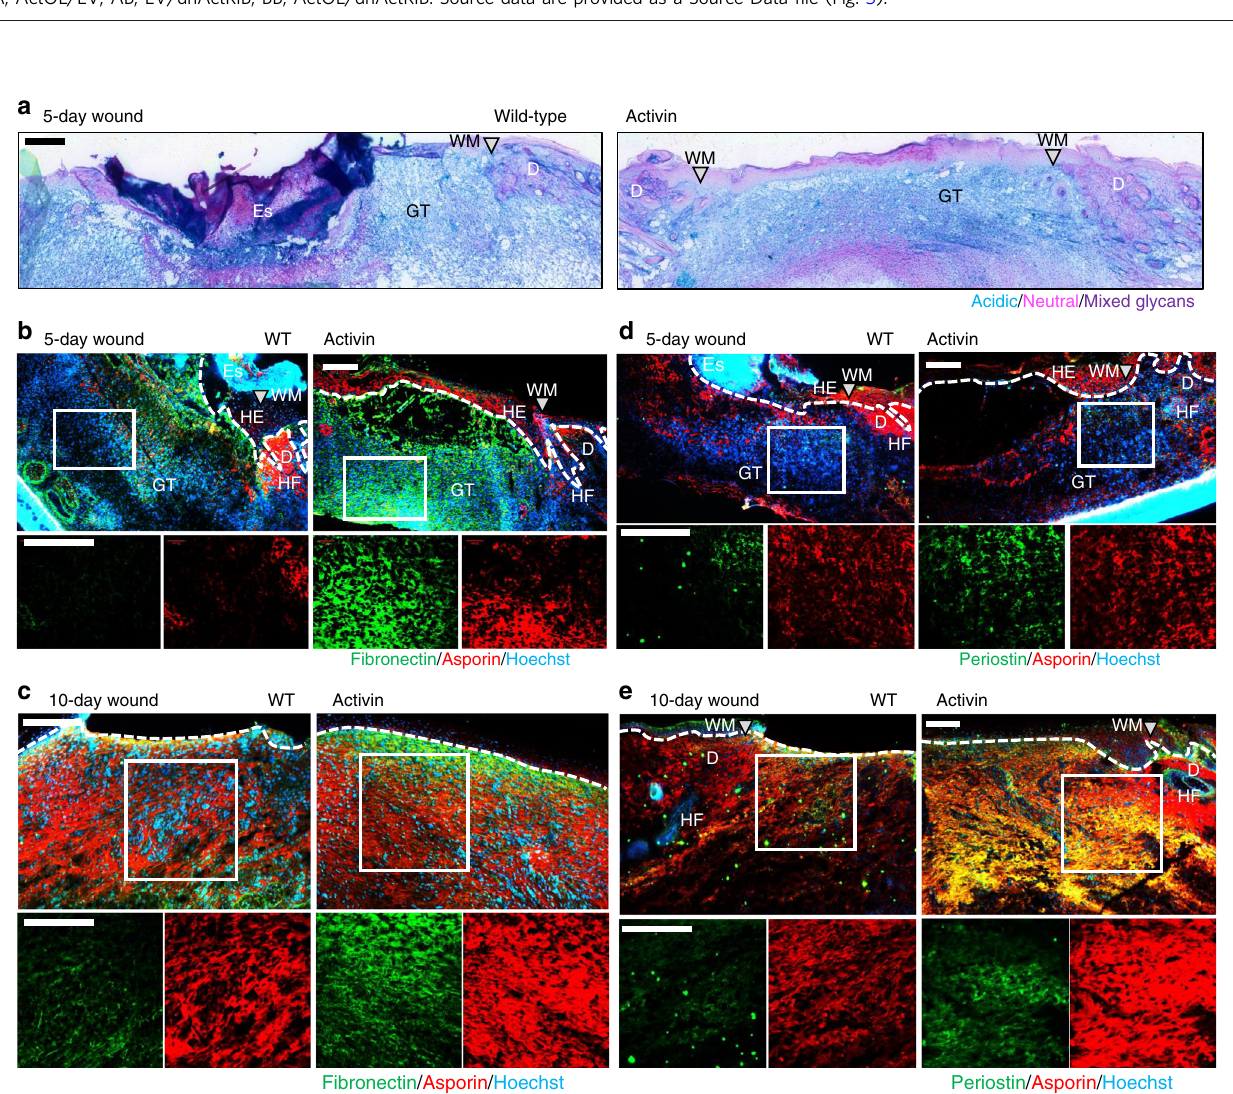
Fig. 6 Activin promotes deposition of wound glycoproteins and proteoglycans. a Representative photomicrographs of Alcian Blue/PAS-stained 5-day wounds show larger areas of acidic (blue) glycans in the wound center of Act vs WT mice. b – e Representative photomicrographs of sections from 5-day ( b , d ) and 10-day wounds ( c , e ) of WT and Act mice stained with antibodies against fi bronectin (green) and asporin (red) ( b , c ) or periostin (green) and asporin (red) ( d , e ). Nuclei were counterstained with Hoechst (blue). Insets indicate the areas within the wound bed centers that are shown at higher magni fi cation below. Stainings were performed on n = 5 wounds from fi ve mice for 5-day wounds and n = 3 for 10-day wounds with similar results. Gray triangles represent wound margins (WM); HE hyperproliferative epithelium, HF hair follicle, D dermis, Es eschar, GT granulation tissue. White dotted lines indicate the border between the dermis/granulation tissue and the epidermis or wound epithelium. Scale bars: 200 μ